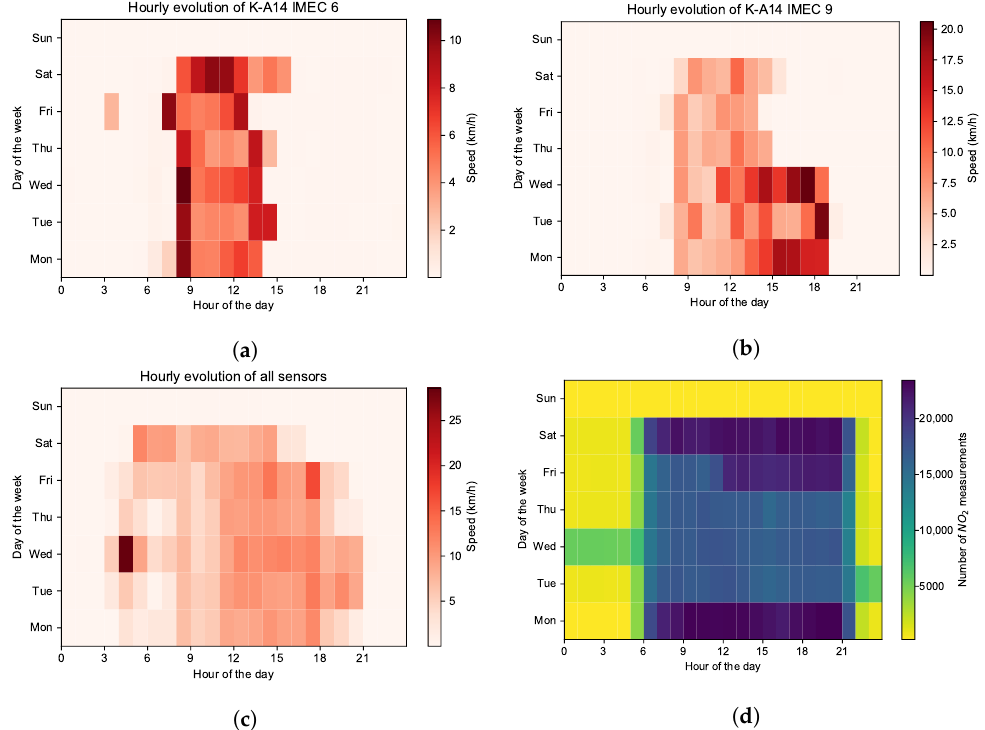
Figure 3. ( a ) The hourly evolution of the speed of mobile sensor K-A14 IMEC 6, ( b ) mobile sensor K-A14 IMEC 8 and ( c ) all mobile sensors during each day of the week on May 2021. ( d ) The hourly evolution of the number of NO 2 measurements collected by all mobile sensors during each day of the week on May